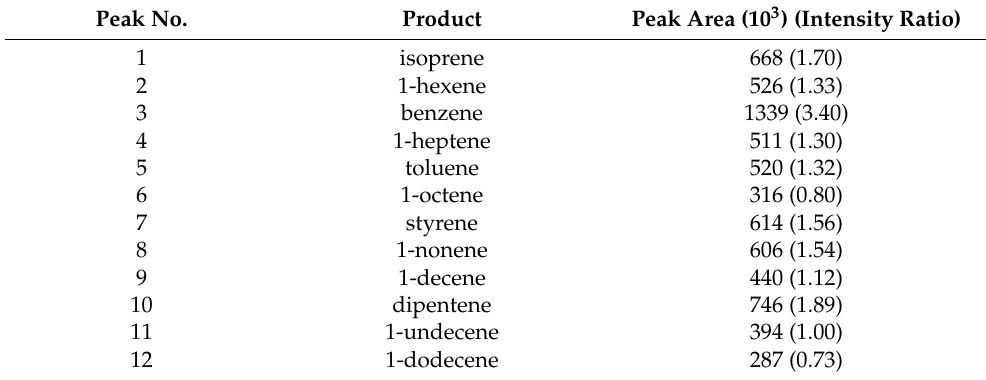
Figure 2. Py-GC/MS chromatograms of the PM 2.5 (1), PM 2.5 (2), PM 2.5 (3), and PM 2.5 (4) samples. Table 1. Peak areas and relative intensity ratios (the reference: 1-undecene) of the major pyrolysis products detected in the PM 10 sample.